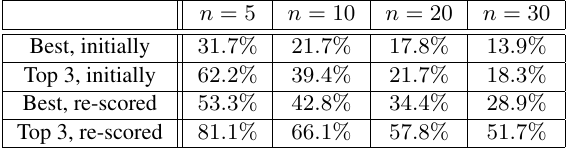
Table 1: Legend recognition results. Top 3 indicates that the cor- rect word is among the three most probable words